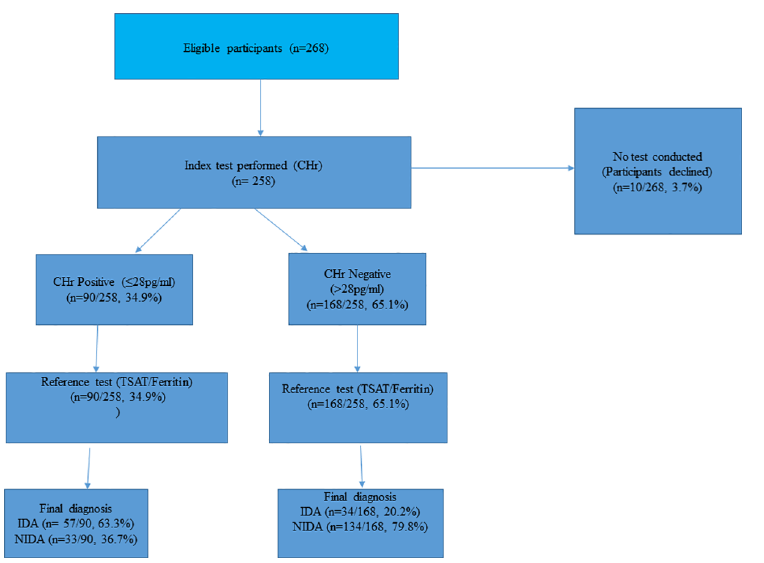
Fig 1. Flow chart of study